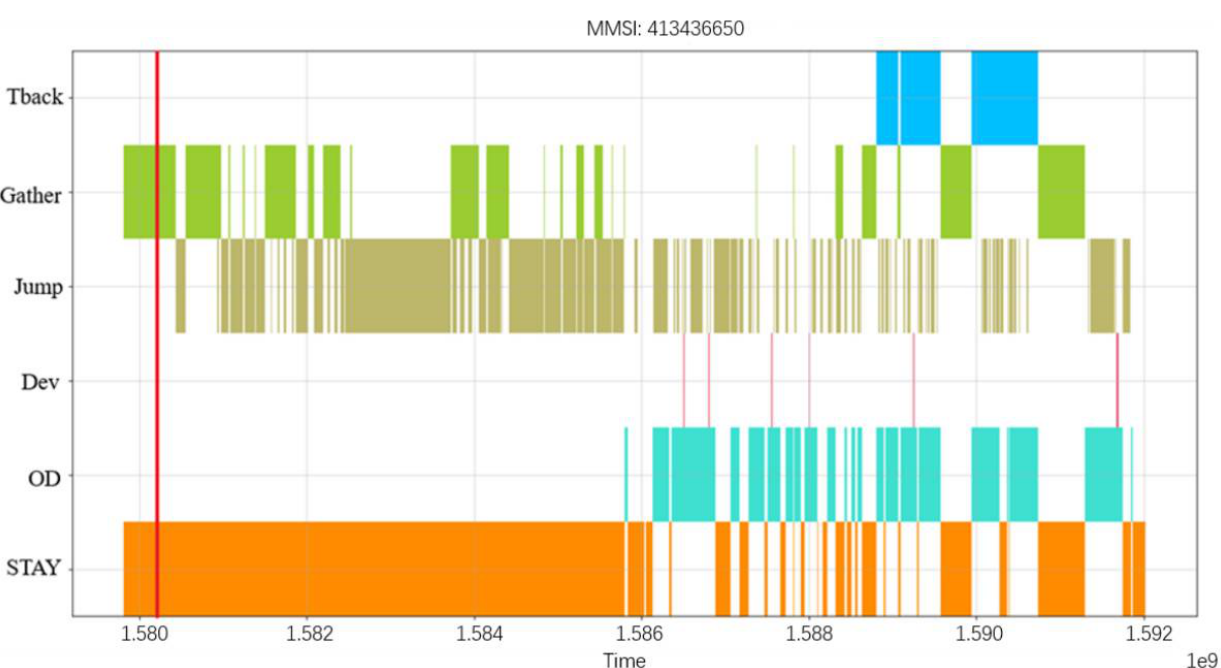
Figure 11. Involved ship complex behavioral pattern diagram.